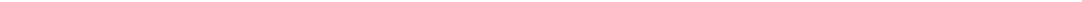
molecules in HUVECs. HUVECs, pretreated for 30 min with 10 µ M NBMPR, were incubated with 100 µ M adenosine for 30 min and then stimulated with